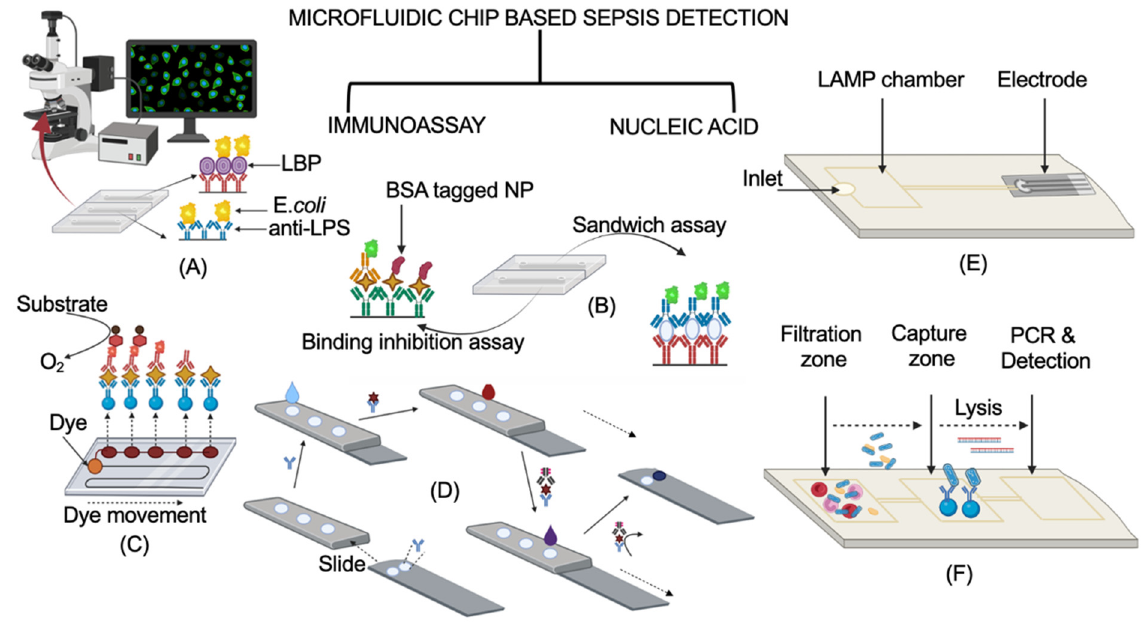
Figure 7. A schematic representation of two types of microfluidic chip biosensors for the detection of sepsis. ( A – D ) are categorized as immunoassay-based microfluidic chip biosensors, while ( E ) and ( F ) are nucleic-acid microfluidic chip biosensors. ( A ) E.coli -detecting ELISA-based microfluidic chip biosensor . Adapted from ref. [86]. ( B ) Sepsis biomarkers detecting ELISA-based microfluidic chip biosensor . Adapted from ref. [87]. ( C ) ELISA-based POC for sepsis biomarkers . Adapted from ref. [88]. ( D ) Sliding strip 3D-micropad immunoassay-based microfluidic chip biosensor . Adapted from ref. [89]. ( E ) LAMP and hybridization-based electrochemical microfluidic chip biosensor . Adapted from ref. [90]. ( F ) Lab-on-chip for sepsis detection . Adapted from ref. [91]. The representation of the